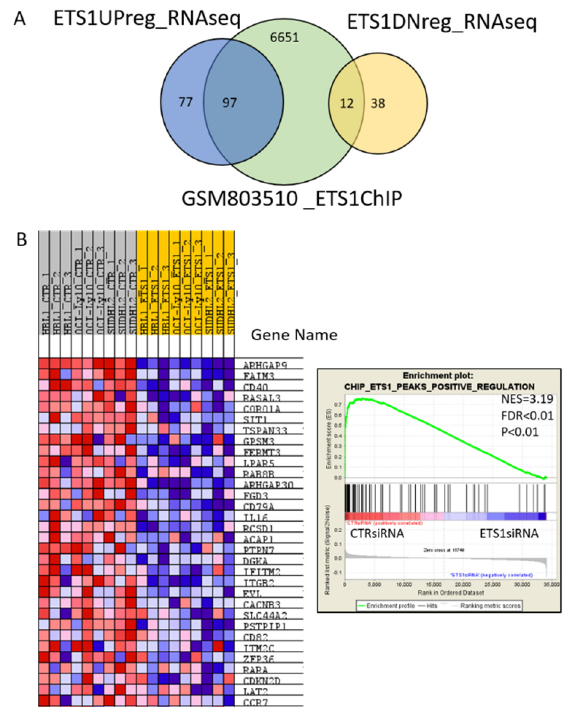
Figure 2. Direct ETS1 targets identified in gene expression profiling data for ABC-DLBCL cell lines with or without ETS1 knockdown. ( A ) Overlap of significant ETS1 upregulated or downregulated genes, identified from RNA-Seq data of CTR siRNA compared to ETS1 siRNA-treated TMD8 and U-2932 cell lines, with putative ETS1 targets from the publicly available Chip-Seq dataset GSM803510 obtained from B lymphoblasts. ( B ) Heatmap showing the GEP profile data (HBL1, OCI-Ly10, SU-DHL-2) for the top featured genes in the gene set for ETS1 positively regulated direct target genes identified in the RNA-Seq and ChIP-seq overlap. Expression values in the heatmap (high, moderate, low, lowest) are represented by a color range (red, pink, light blue, dark blue). In the GSEA plot: Green curve, enrichment score; bars in the middle portion of the plots show where the members of the gene set appear in the ranked list of genes; positive or negative ranking metric indicates, respectively, correlation or inverse correlation with the profile; NES, normalized enrichment score; FDR, false discovery rate.